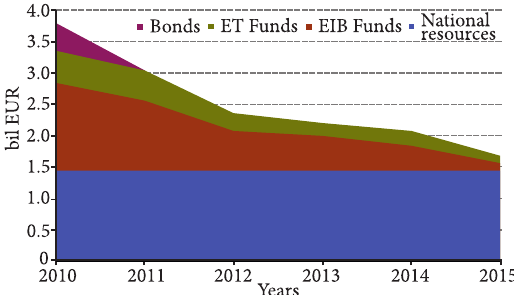
Fig. 17. Graph – available resources in the Czech Republic Table 4. The price index base (100% = average of the EU)